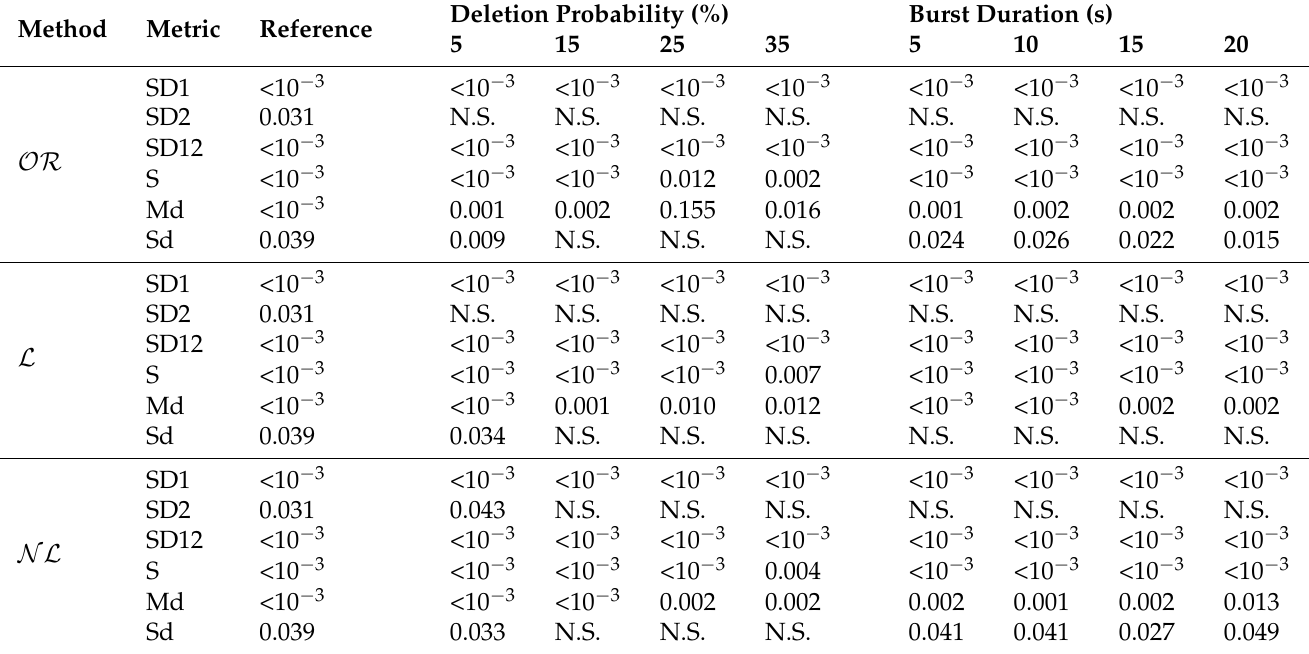
Table 11. p -values of ranked signed test for supine/tilt discrimination of Poincaré metrics. N.S.: Not Significative ( p >